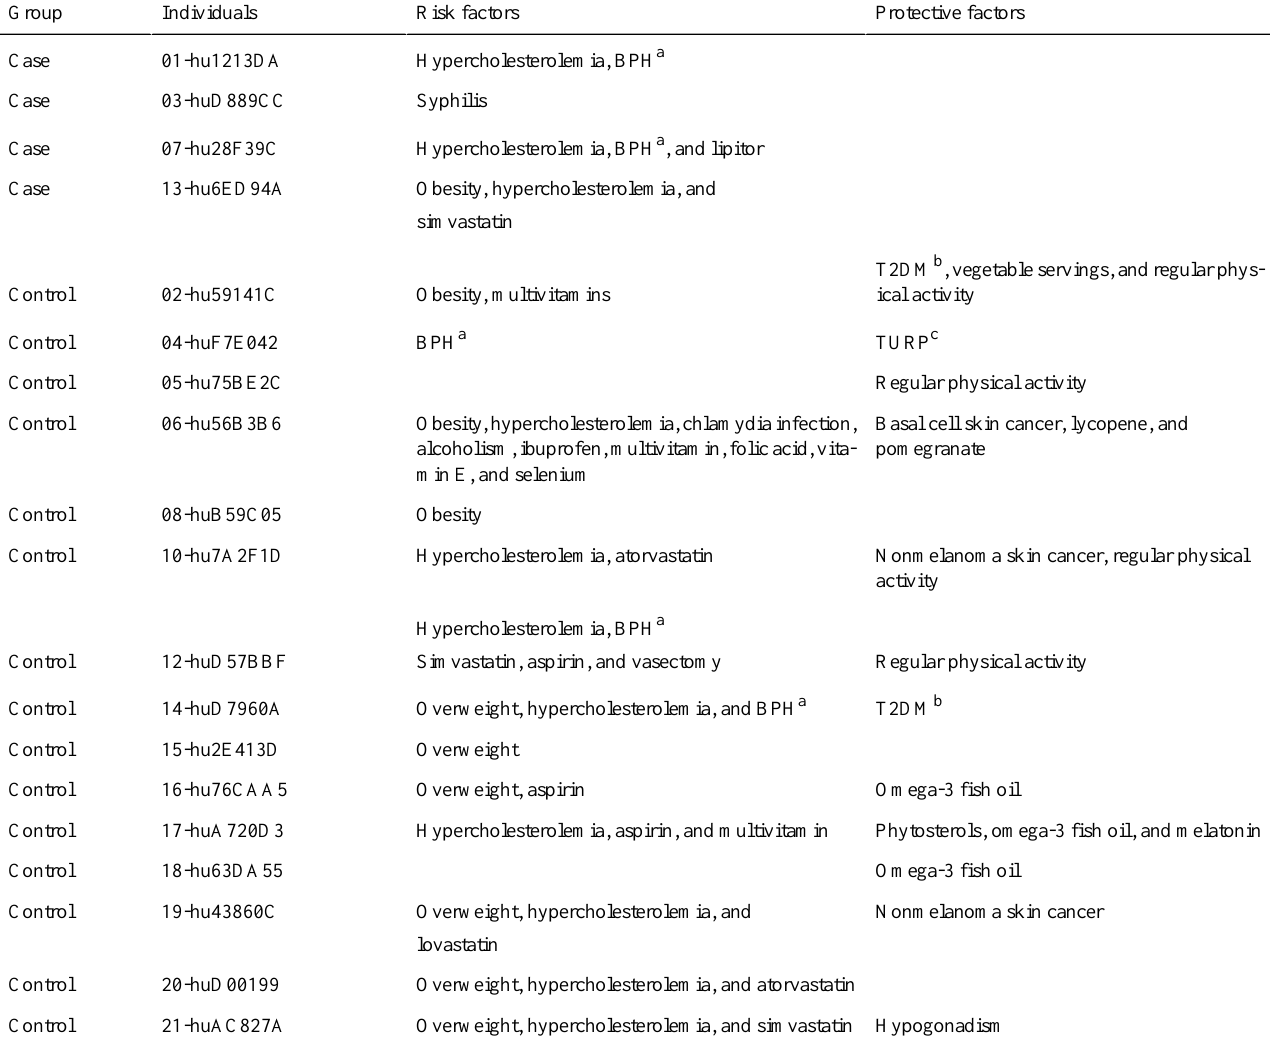
Table 10. Clinical and environmental risk factors of cases and control.